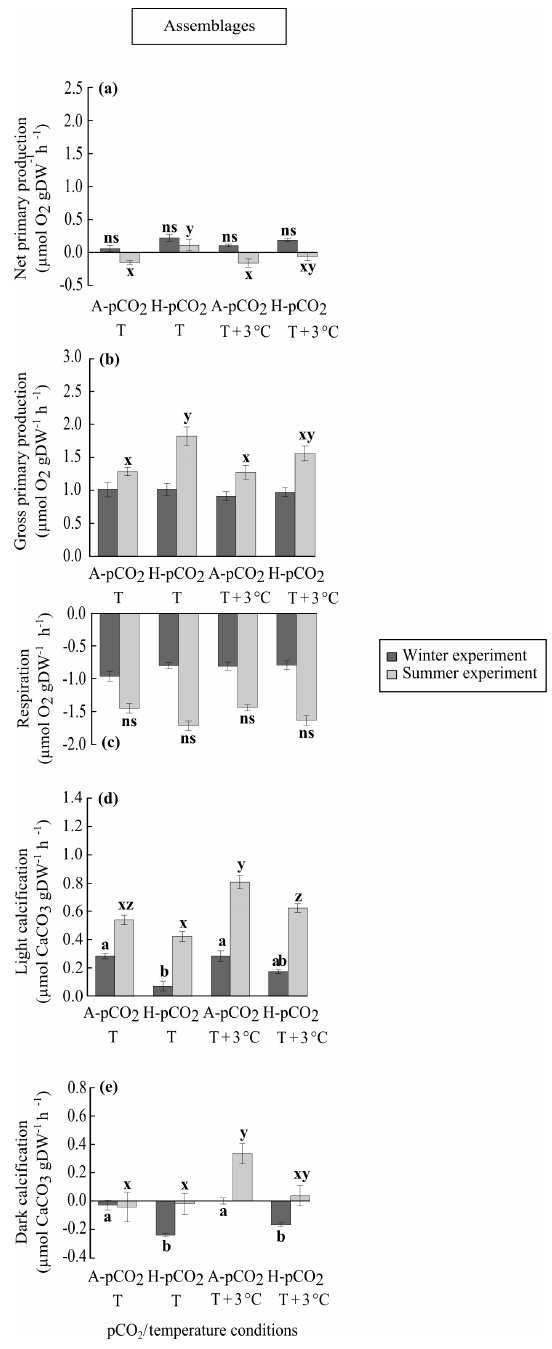
Figure 5. Net and gross primary production ( a and b , respectively), respiration (c) , and light and dark calcification rates ( d and e , re- spectively) rates (mean ± SE, n = 5) of assemblages in the different p CO 2 (A- p CO 2 is ambient p CO 2 ; H- p CO 2 is high- p CO 2 ) and temperature ( T is ambient temperature; T + 3 ◦ C is high tempera- ture) treatments. The assemblages were maintained during 3 months in winter (dark gray) and summer conditions (light gray). Letters in- dicate significant differences between the four treatments in winter (a, b, c) and summer (x, y, z) conditions (Tukey HSD test). ns is not significant. Tukey tests were performed when a significant effect of temperature or p CO 2 was detected using two-way